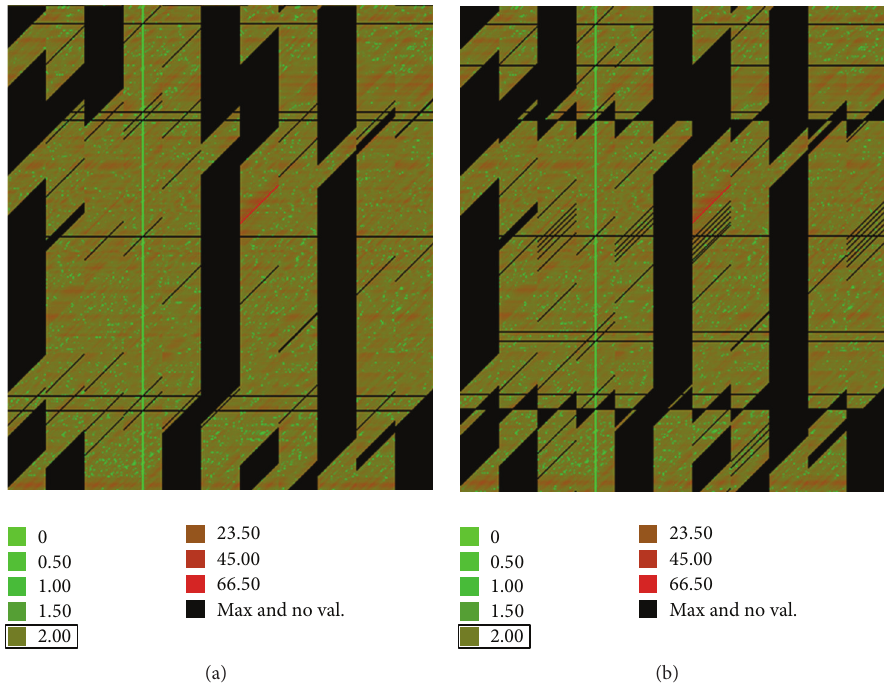
Figure 6: Bitmaps of the thermal distances as a result of the second (a) and third (b) stages. Table 2: Fragment of the thermal distances ( ∘ C) file corresponding to February 10,